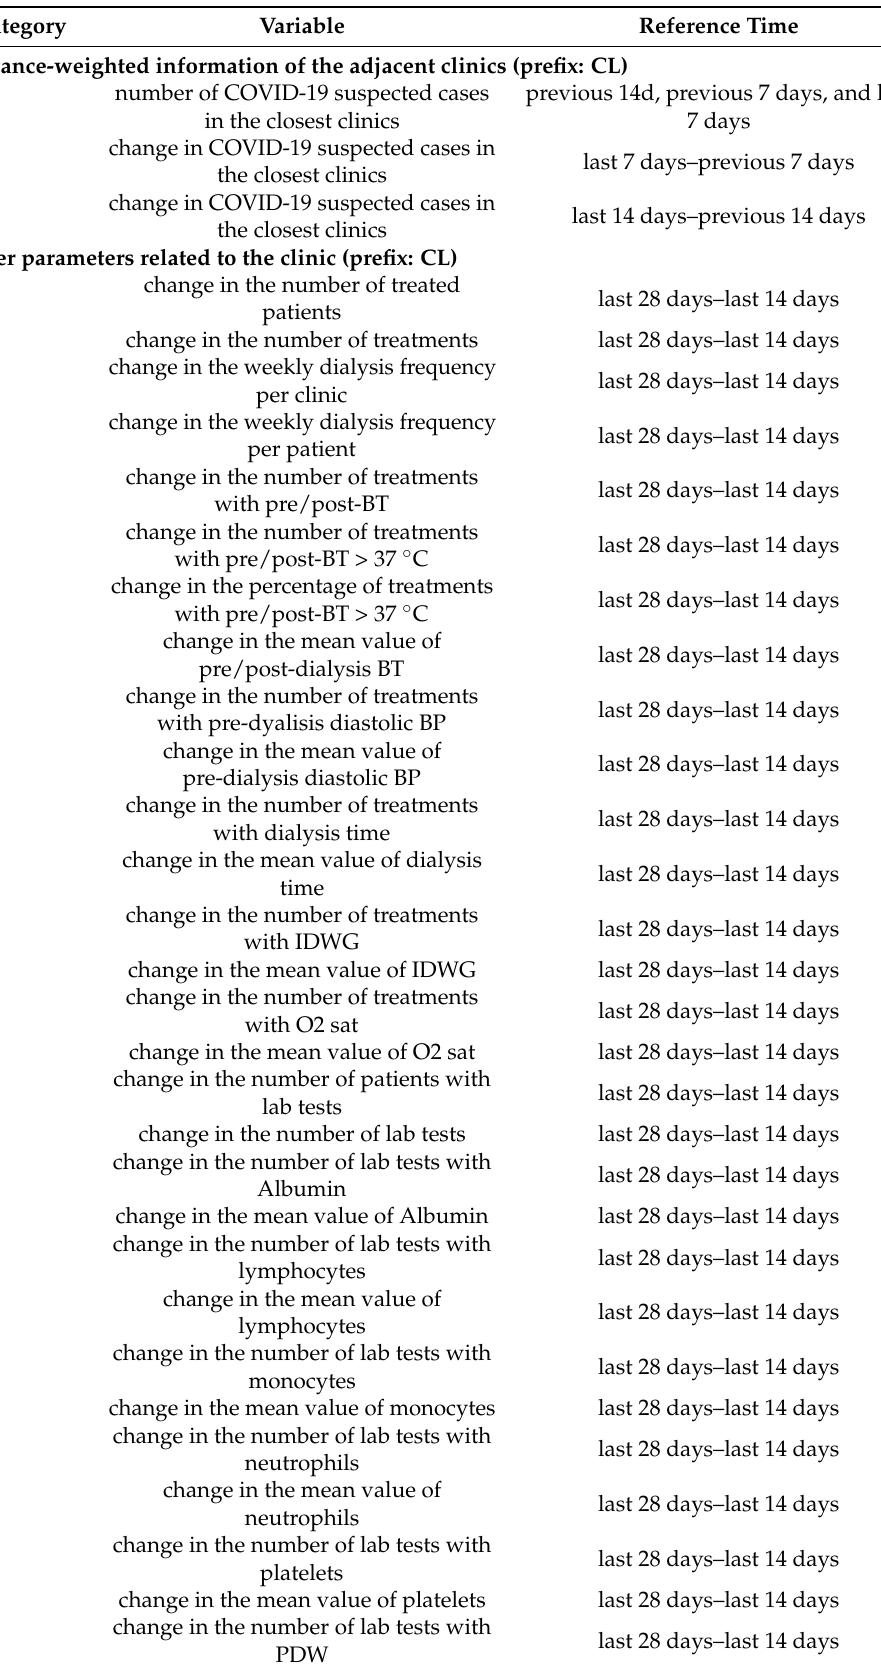
Table A1. Cont. Category Variable Reference Time distance-weighted information of the adjacent clinics (prefix: CL) number of COVID-19 suspected